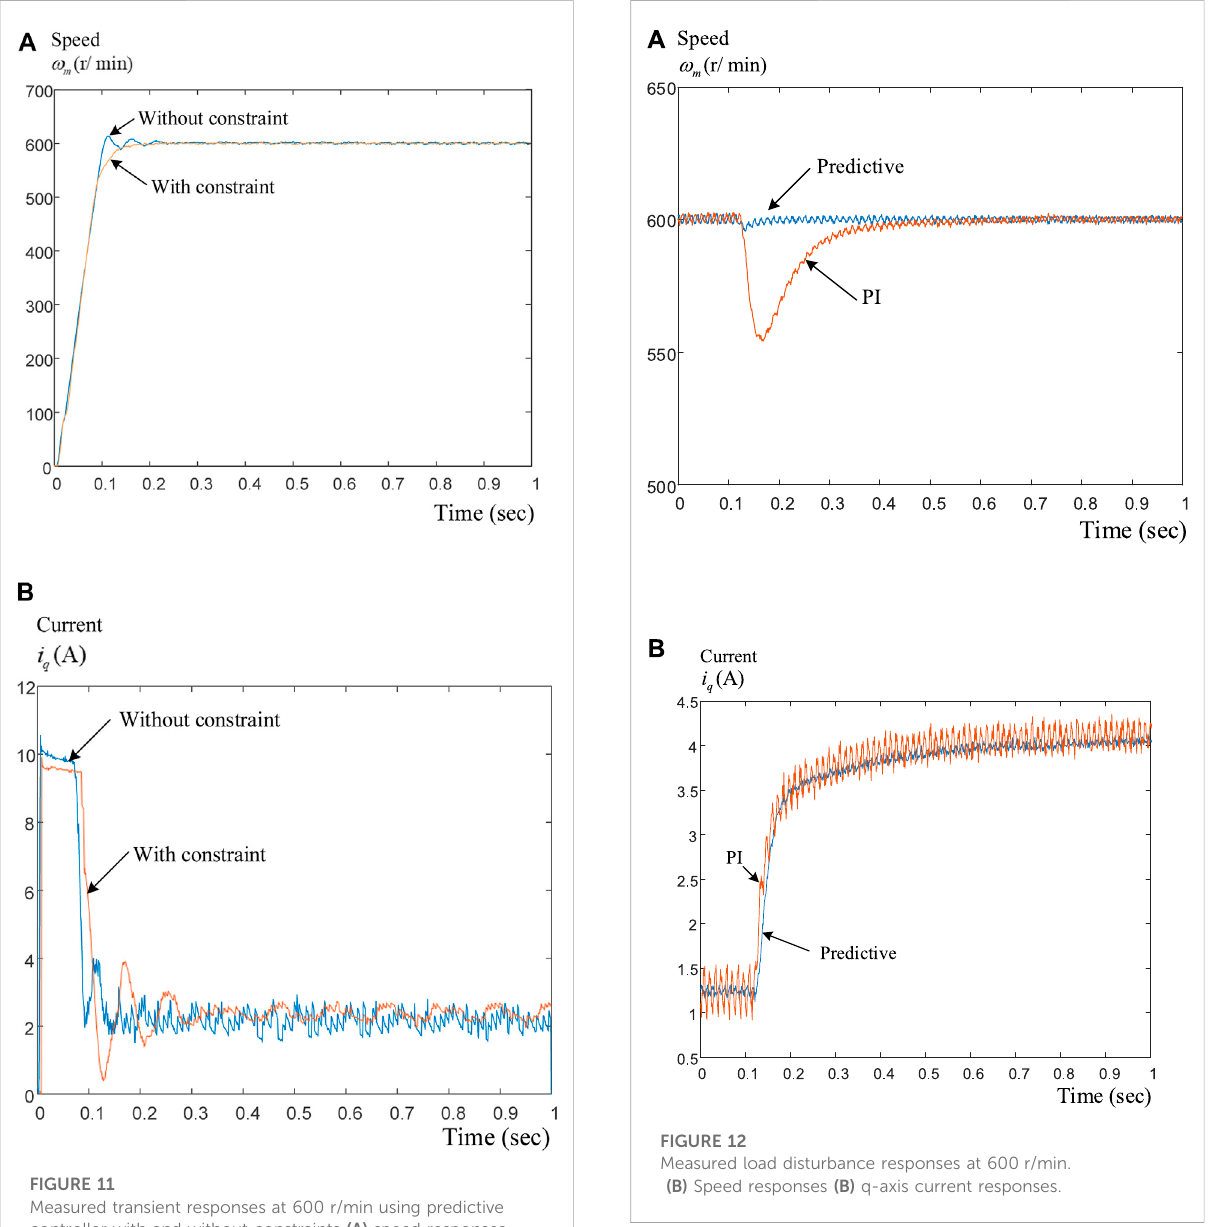
FIGURE 12 Measured load disturbance responses at 600